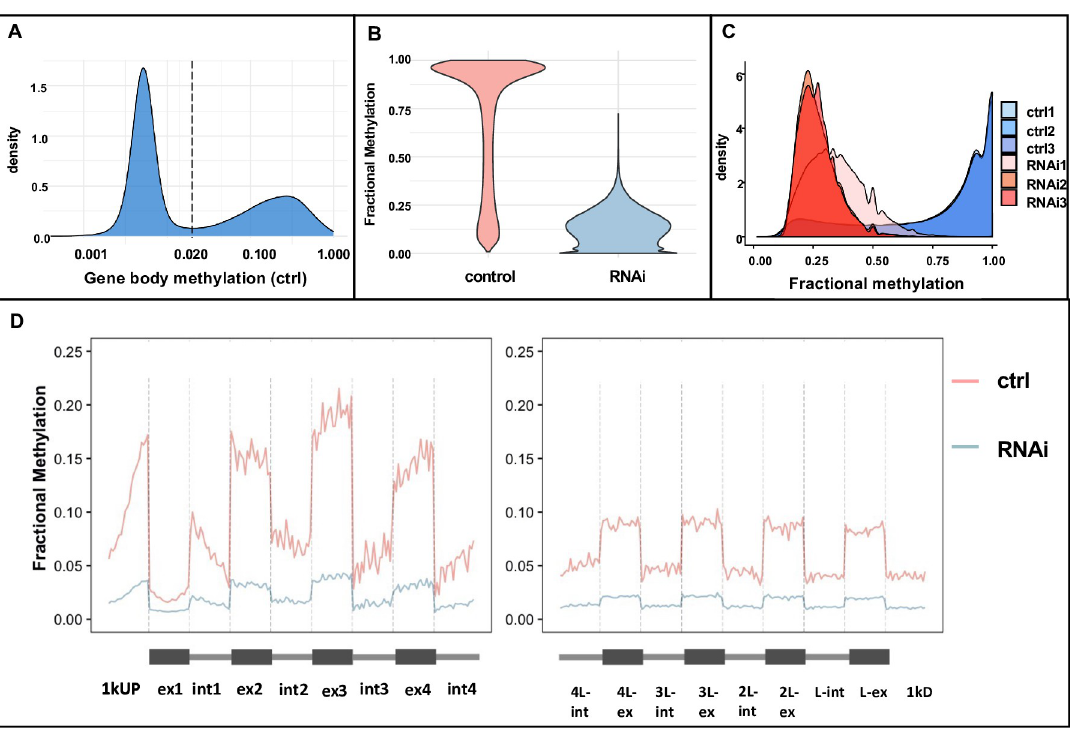
Fig 3. Global DNA methylation in control and Nv-dnmt1a pRNAi late blastoderm N . vitripennis embryos. (A) An example of distribution of fractional DNA methylation in a control sample exhibiting the classical bimodal distribution. We defined methylated genes as genes with a minimum of 0.02 gene body methylation (shown as the dashed line) to classify methylated and unmethylated genes. (B) Violin plot demonstrating the reduction of whole genome DNA methylation in Nv-dnmt1a pRNAi samples compared to the control samples. We calculated the average fractional methylation of all methylated CpGs in the control samples and corresponding positions in the pRNAi samples (~151k methylated CpGs). (C) Distributions of fractional methylation of CpGs that are methylated at least one control sample demonstrate that CpGs lose DNA methylation in RNAi embryos. (D) The pattern of mean fractional methylation in the first and last four exons and introns of all methylated genes in control and pRNAi samples, divided into equal-sized bins. Control shown in red, pRNAi shown in